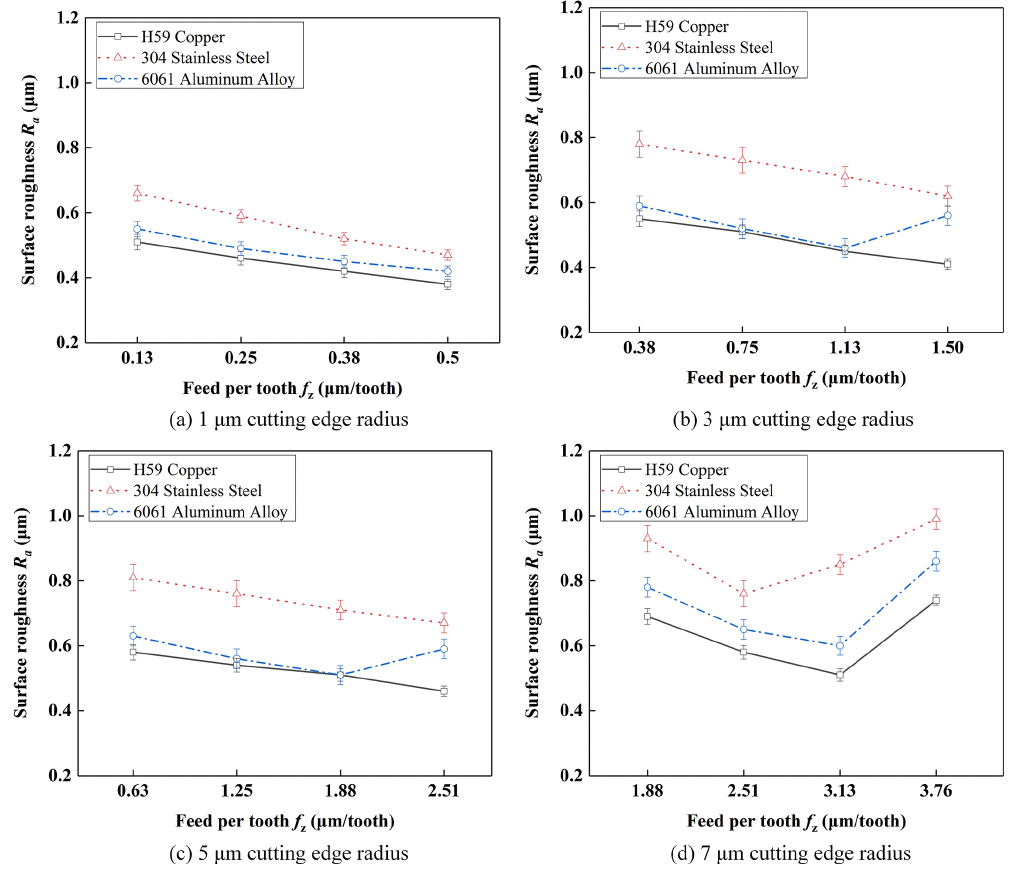
Figure 12. Surface roughness results for the peripheral cutting edge (process no. 2). Table 8. MUCT analysis results of the end cutting edge. MUCT by the chip morphology (µm) and MUCT by the surface roughness (µm) End